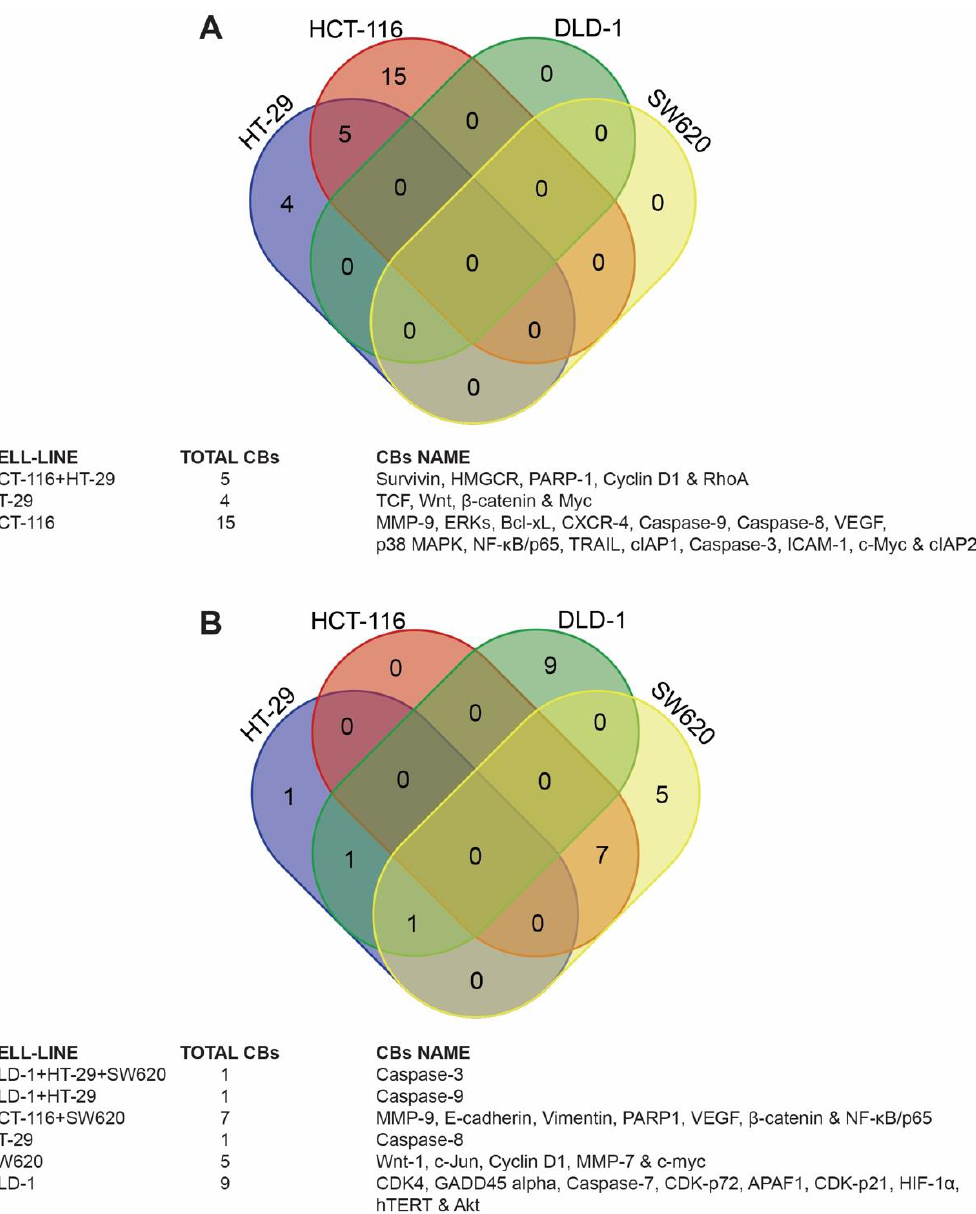
Figure 4. Venn diagrams illustrating the unique candidate genes and proteins present in the cell lines with the highest research usage (HT-29, HCT-116, DLD-1, and SW620) following exposure to T3 analogues. ( A ) Gamma-tocotrienol (γT3); ( B ) Delta-tocotrienol (δT3).